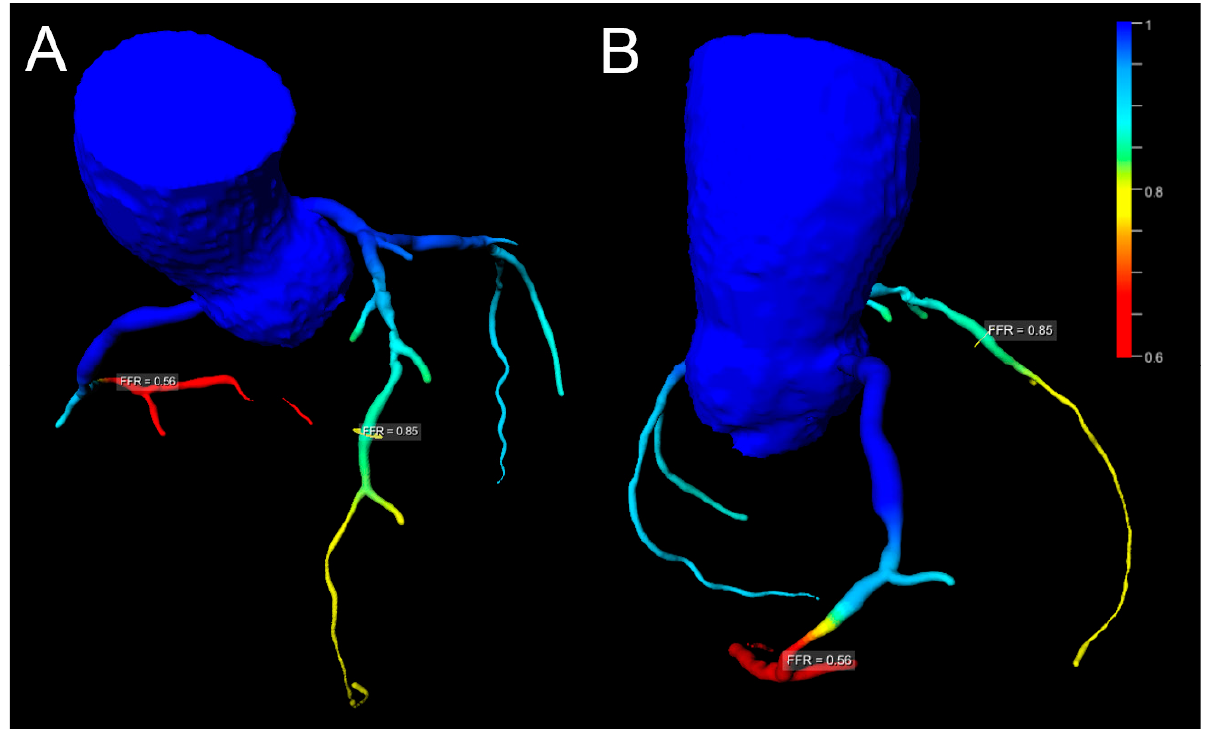
Figure 3. Imaging of a cCTA with non-invasive CT-FFR measurements. 65-year-old male patient referred for suspected CAD. Three-dimensional reconstruction of the coronary tree with color-coded FFR calculations. These show a hemodynamically relevant stenosis in the distal right coronary artery (( B ), FFR 0.56), whereas stenosis in the distal LAD ( A ) is not hemodynamically relevant (FFR 0.85). Courtesy of Sebastian J. Buss, MVZ-DRZ Heidelberg, Germany.